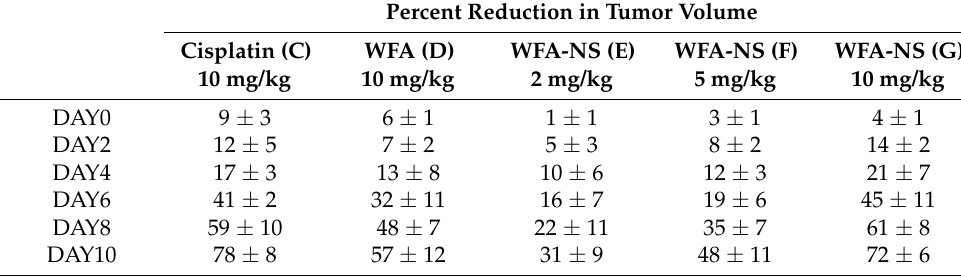
Table 2. The numerical data provides percent reduction in tumor volume after giving doses (mg/kg of a mouse).